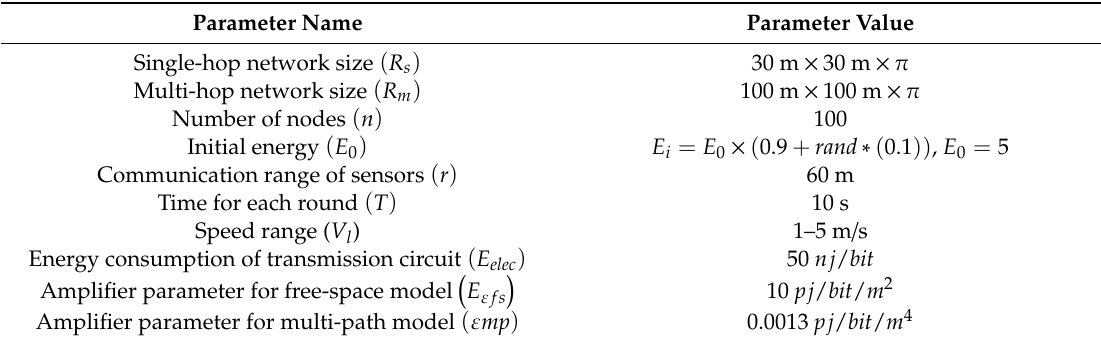
Table 3. Simulation